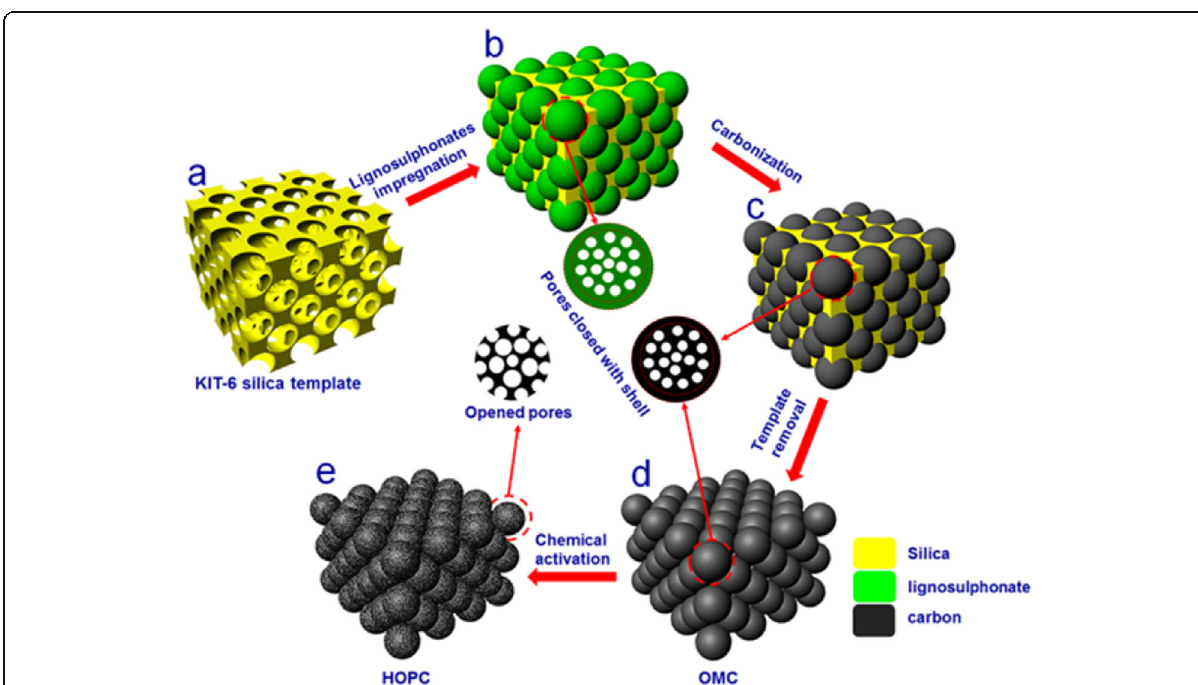
Fig. 1 Illustration of the synthetic processes of hierarchical ordered porous carbon (HOPC) using the hard template method combined with post chemical